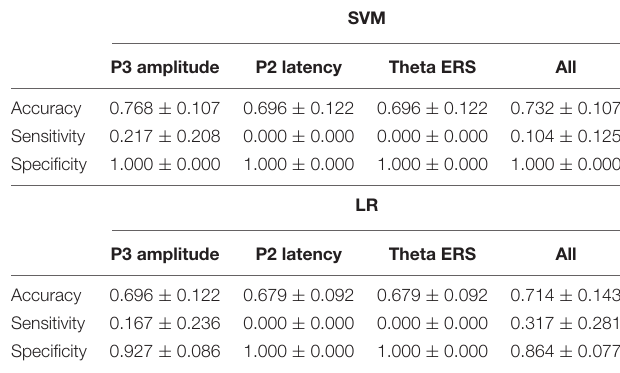
TABLE 6 | Parameters of classification (mean ± standard deviation) of testing